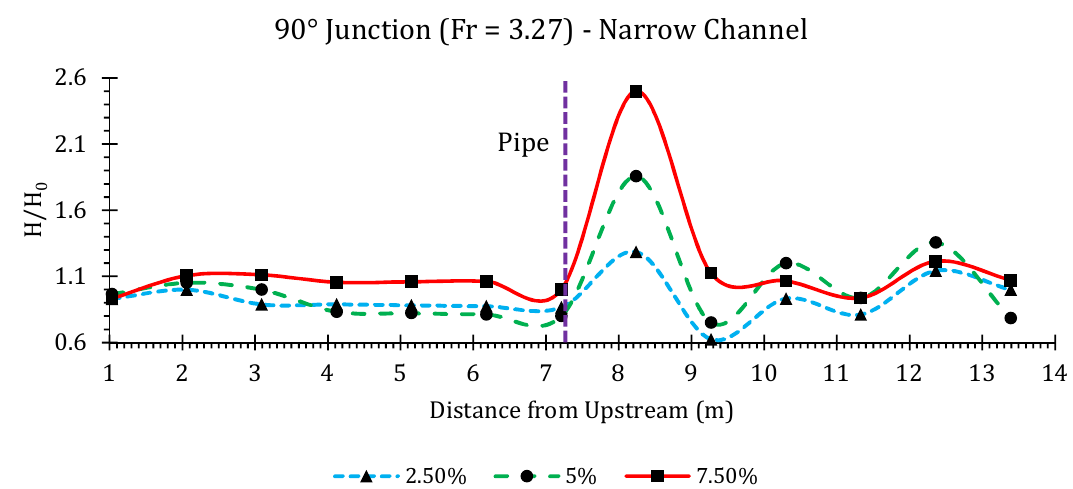
Figure A45. Water height ratios in a 90° junction for Fr = 3.27 in the narrow channel.